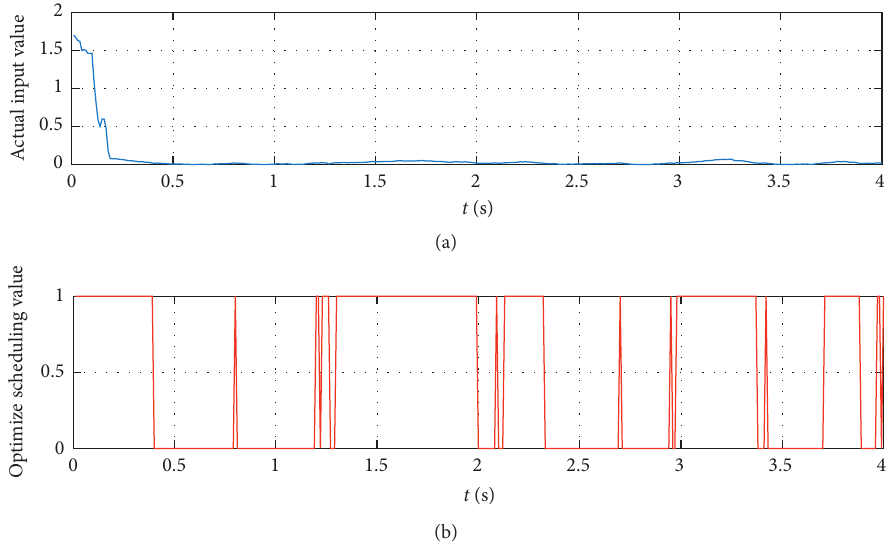
Figure 10: The control input and scheduling value corresponding to initial disturbance